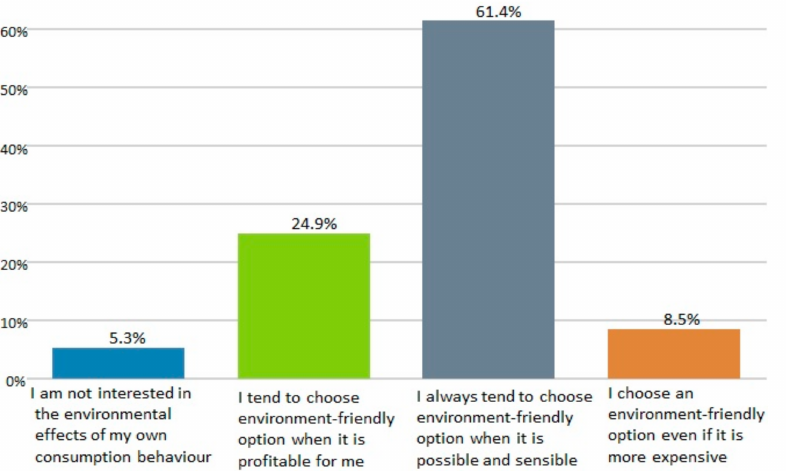
Figure A3. The intentions to influence the environment through their own energy consumption activities.